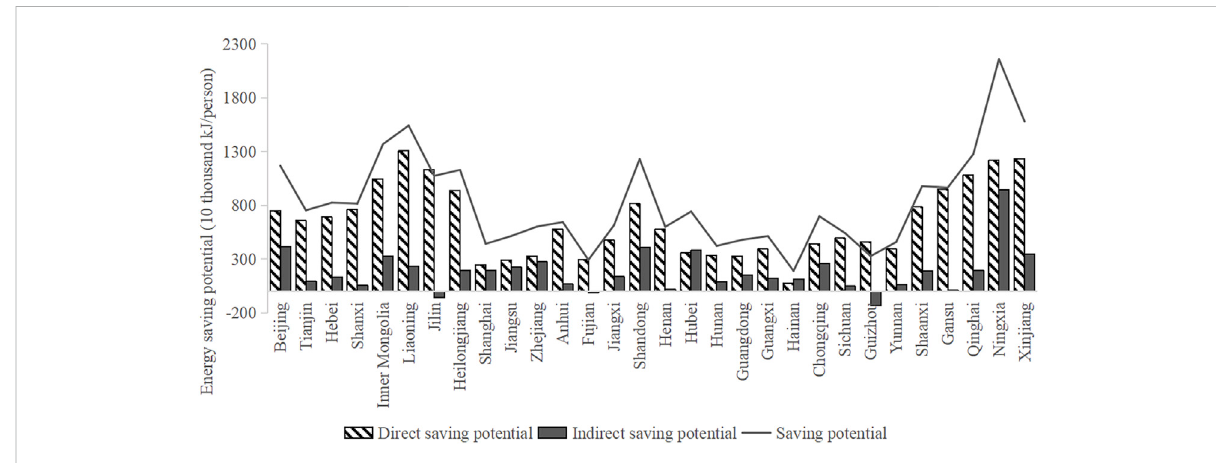
FIGURE 6 Per capita energy consumption under actual situation and DLS by province.